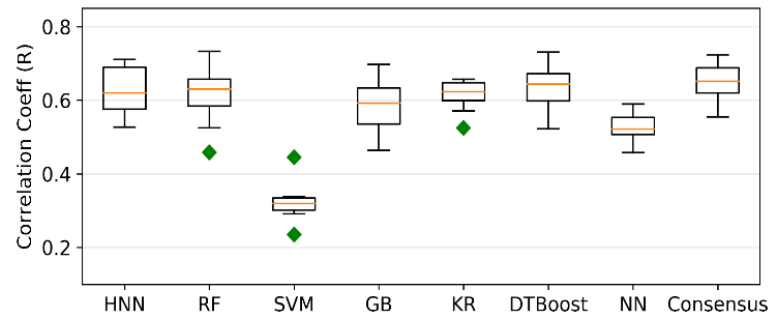
Figure 4. Correlation coefficient (R) of regression models developed based on HNN-Cancer, RF, SVM, GB, KR, DTBoost, NN, and consensus methods.